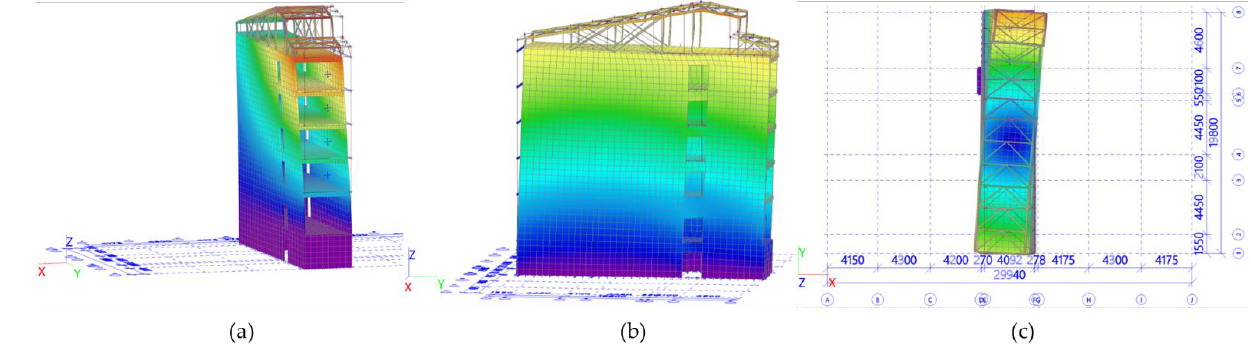
Figure 19. Eigenmodes of Section B: ( a ) translation X; ( b ) translation Y; ( c ) rotation (Z).